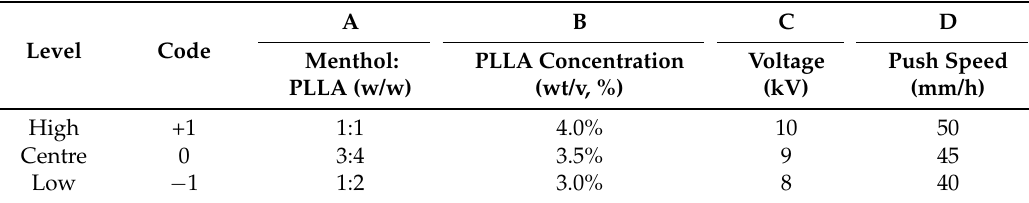
Table 3. Experimental factors and